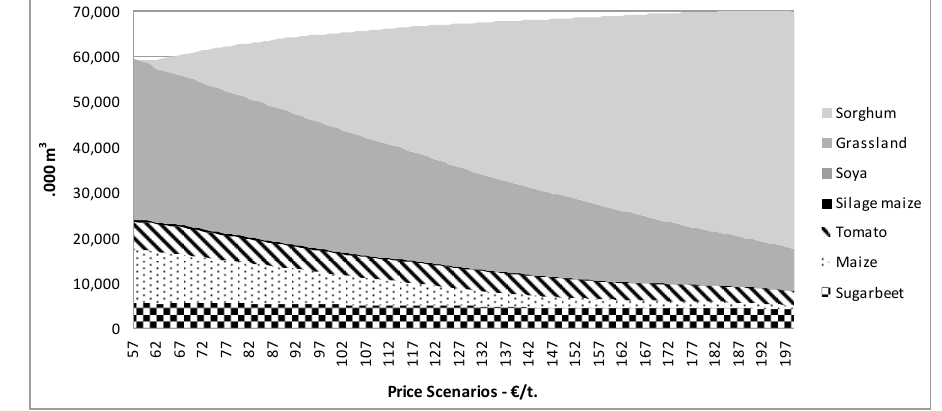
Figure 5. Irrigated water